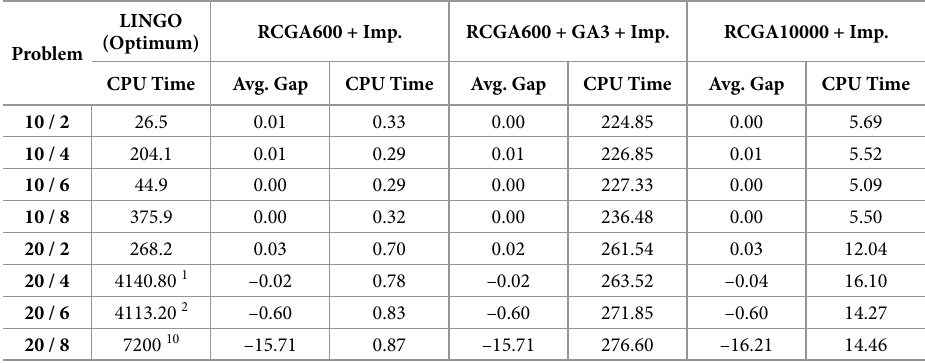
Table 5. Effect of the number of machines on algorithm performance